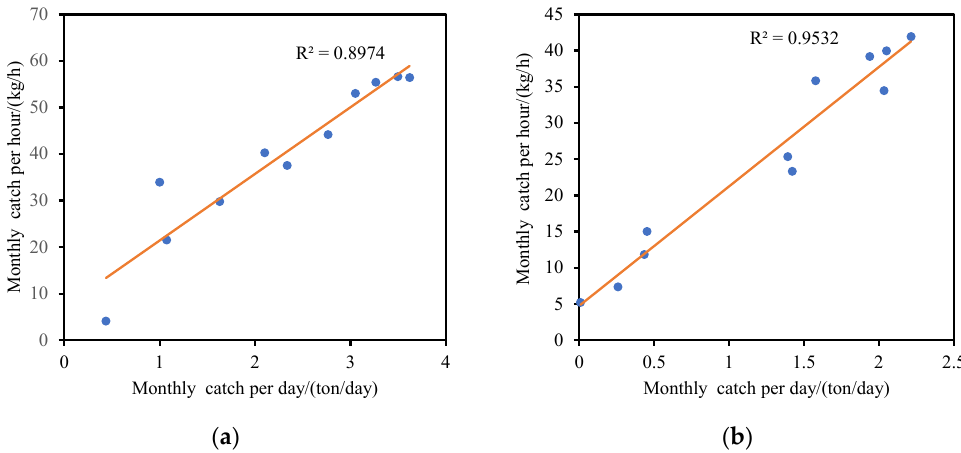
Figure 5. The relationship of mean monthly CPUE between two units: ( a ) nominal CPUE; ( b ) GAM standardized CPUE.